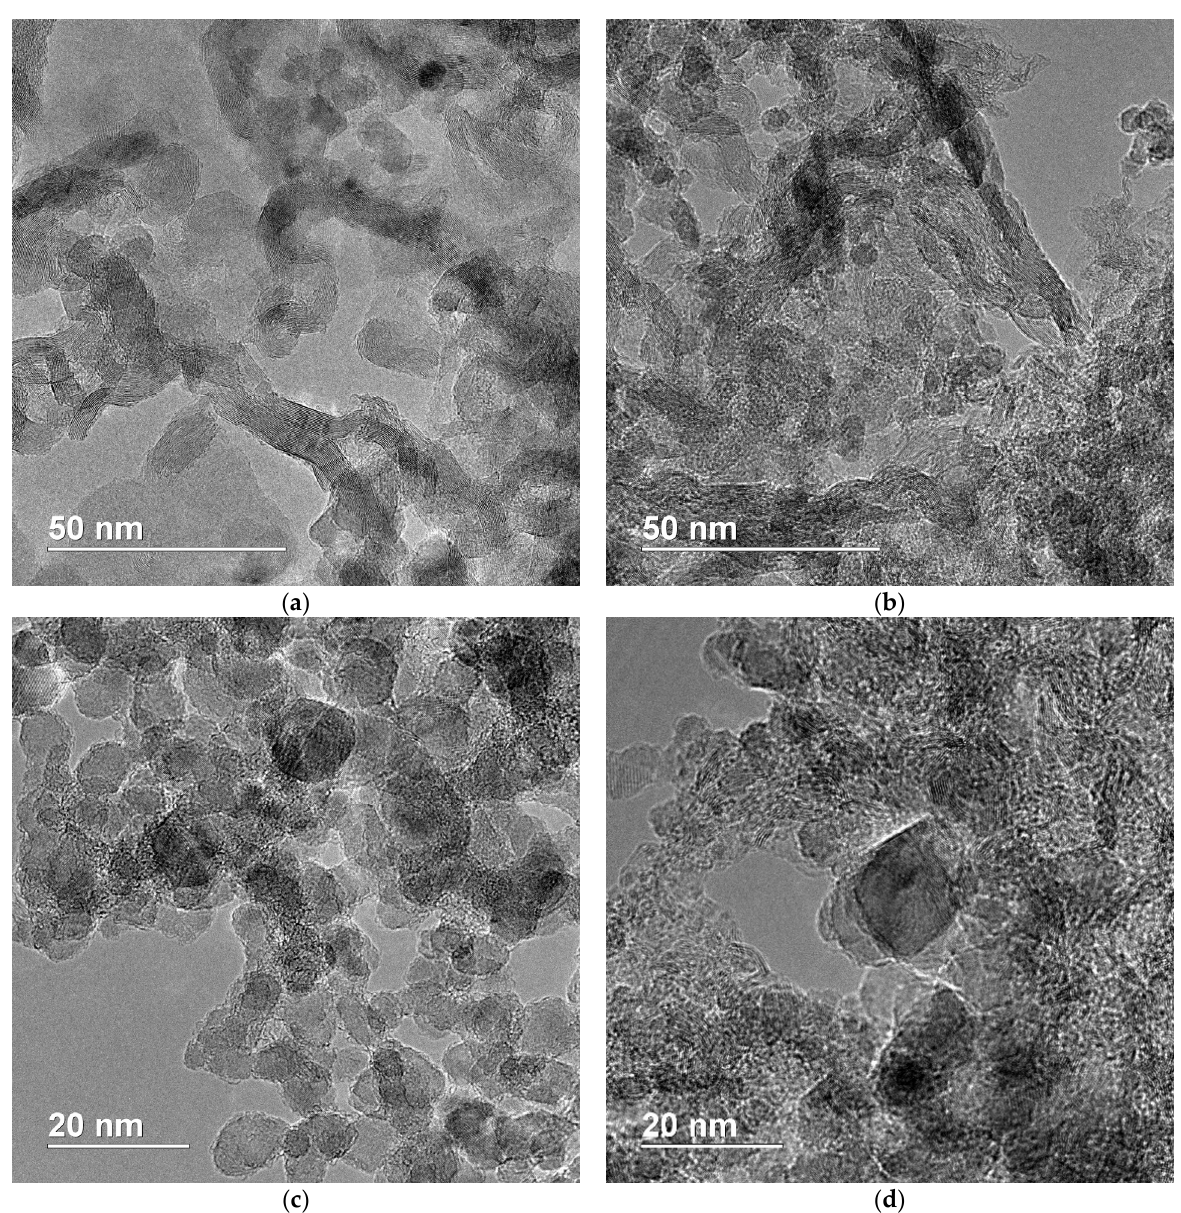
Figure 3. ( a – d ) Transmission electron microscopy images of NDS powder.